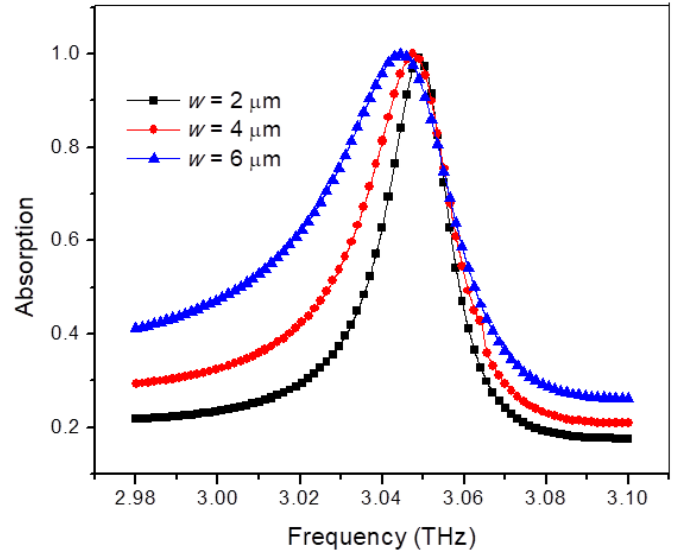
Figure 4. Absorption spectra obtained by varying the width of U-shaped